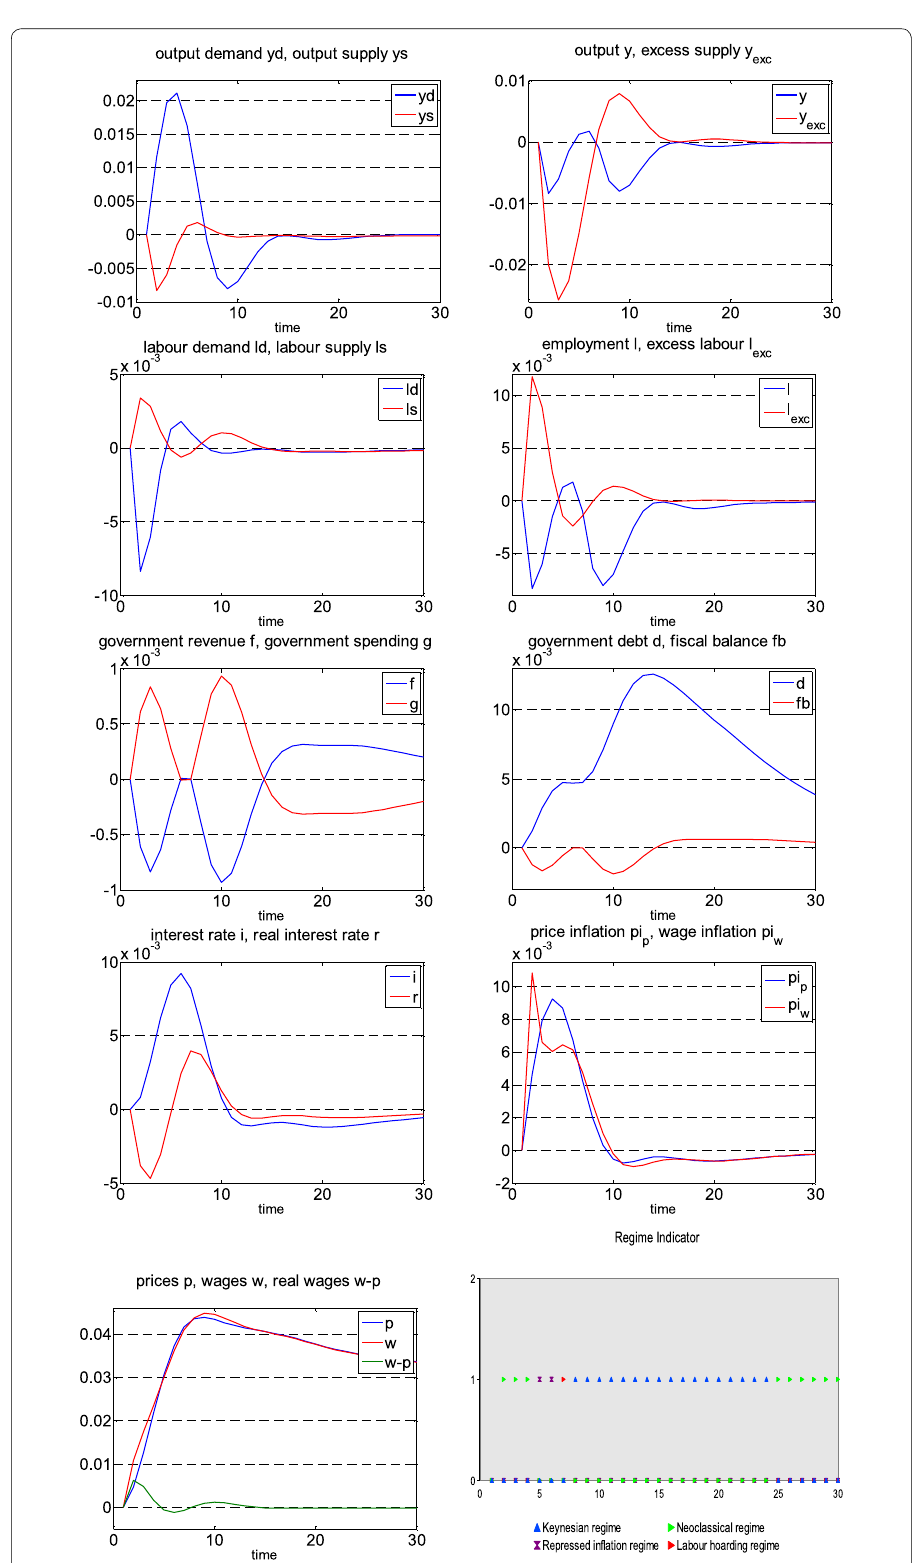
Fig. 6 Effects of a one-time positive wage shock with alternative real price and wage